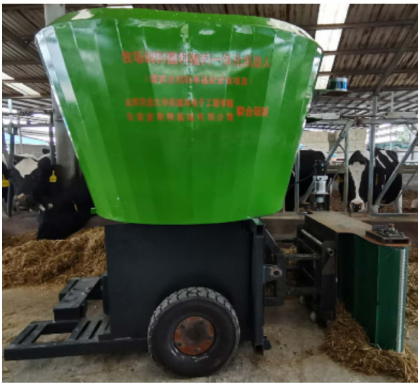
Figure 20. Pusher robot [106].